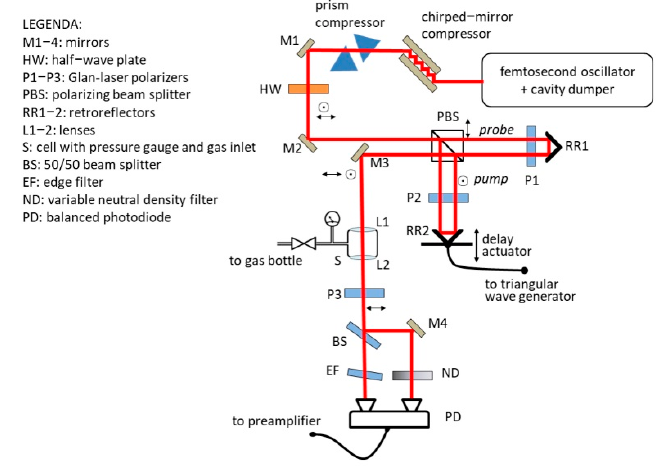
Figure 1. Experimental layout.